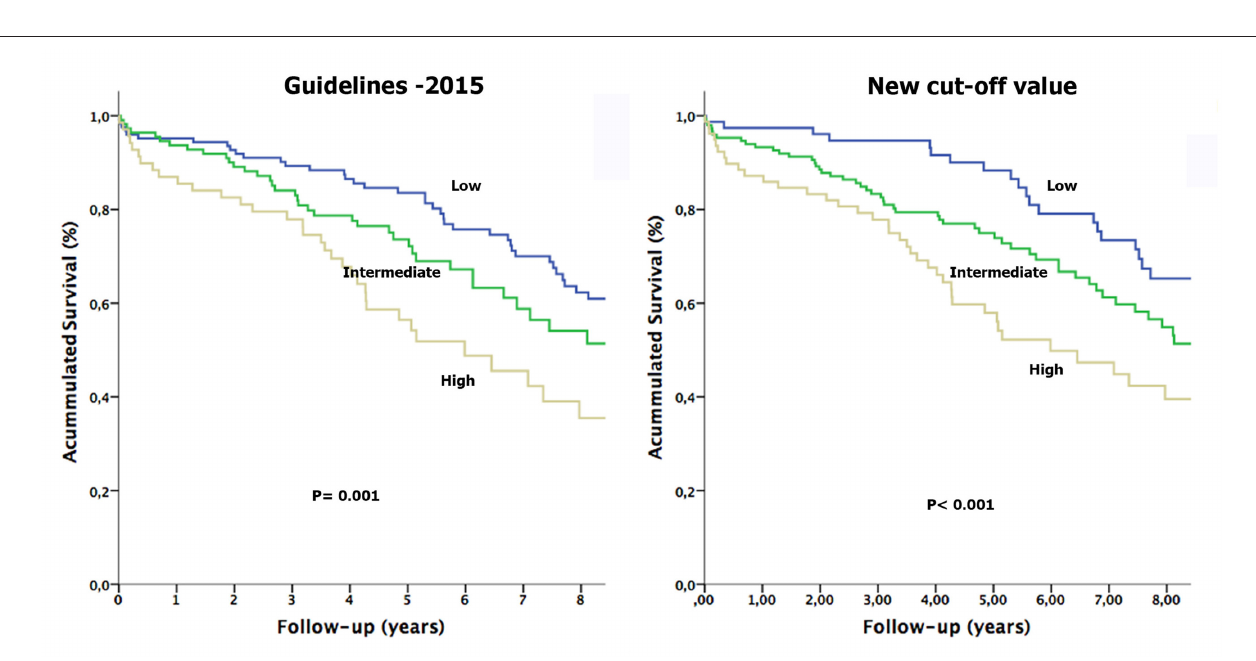
FIGURE 2 | Kaplan-Meier survival curves analysis of patients with tricuspid regurgitation and an intermediate pulmonary hypertension probability compared to the low group, according to ESC/ERS guidelines and the new cut-off point thresholds.